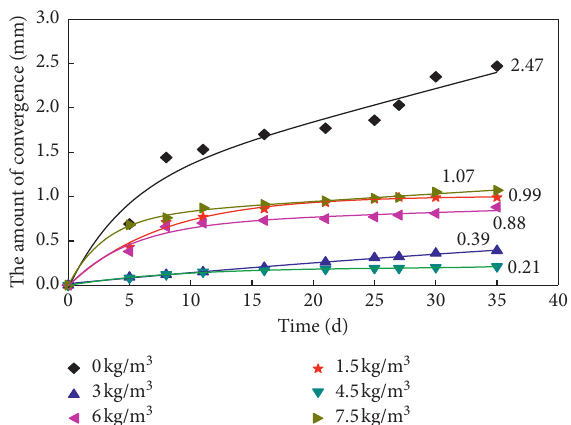
Figure 10: Convergence deformation curve of bottom drainage